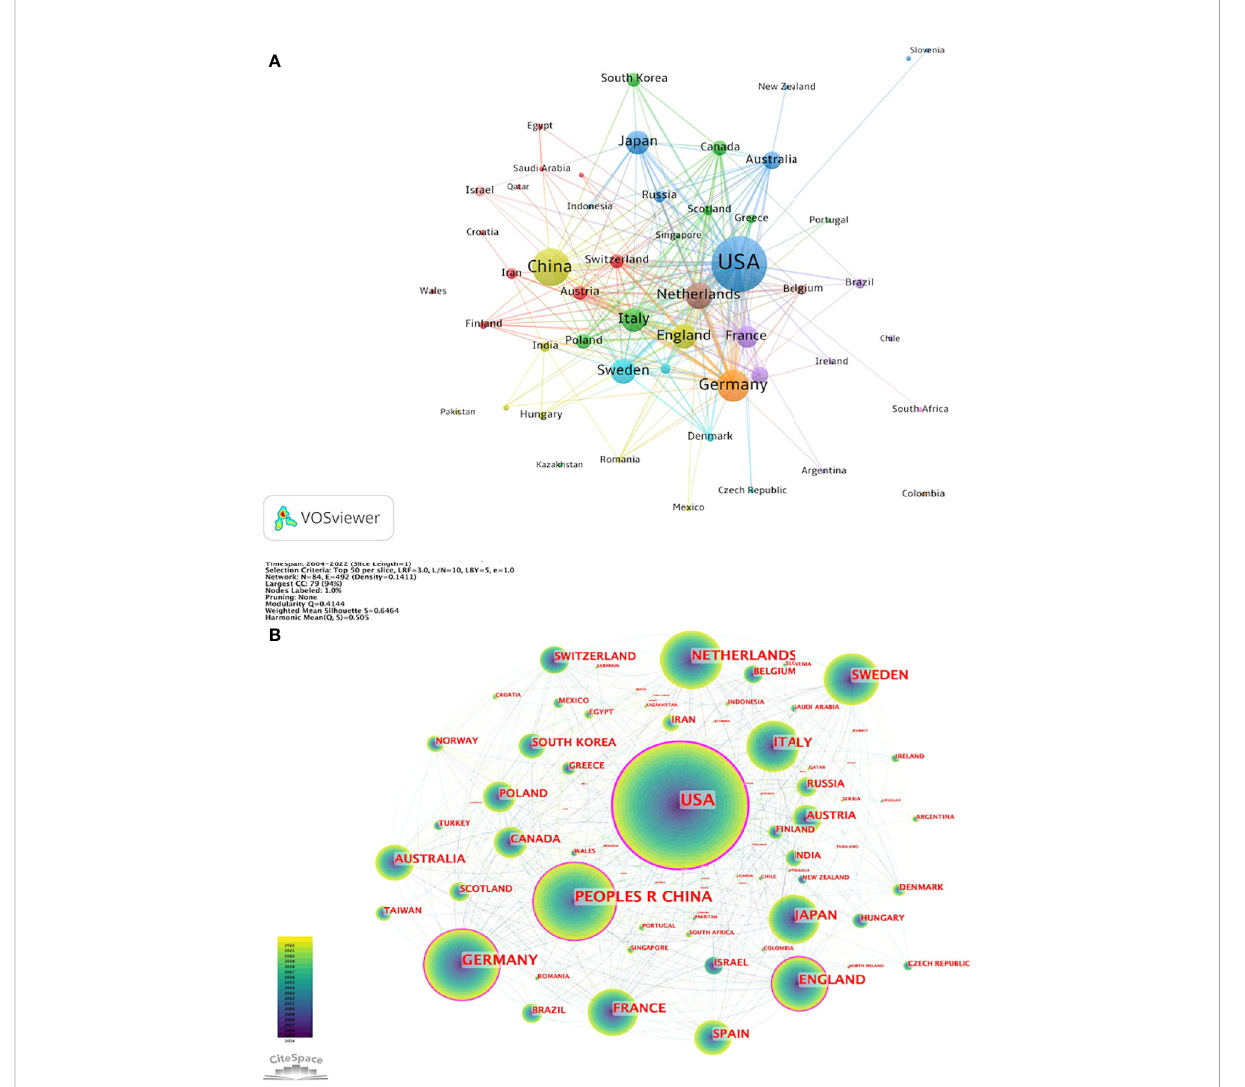
FIGURE 3 Cooperation map of countries/regions in T cell and AS. (A) A visual map for VOSviewer network. (B) A visual map for CiteSpace